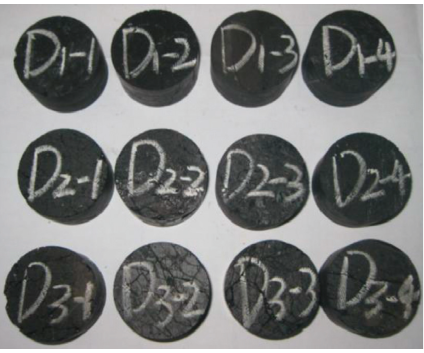
Figure 2: Coal specimens for